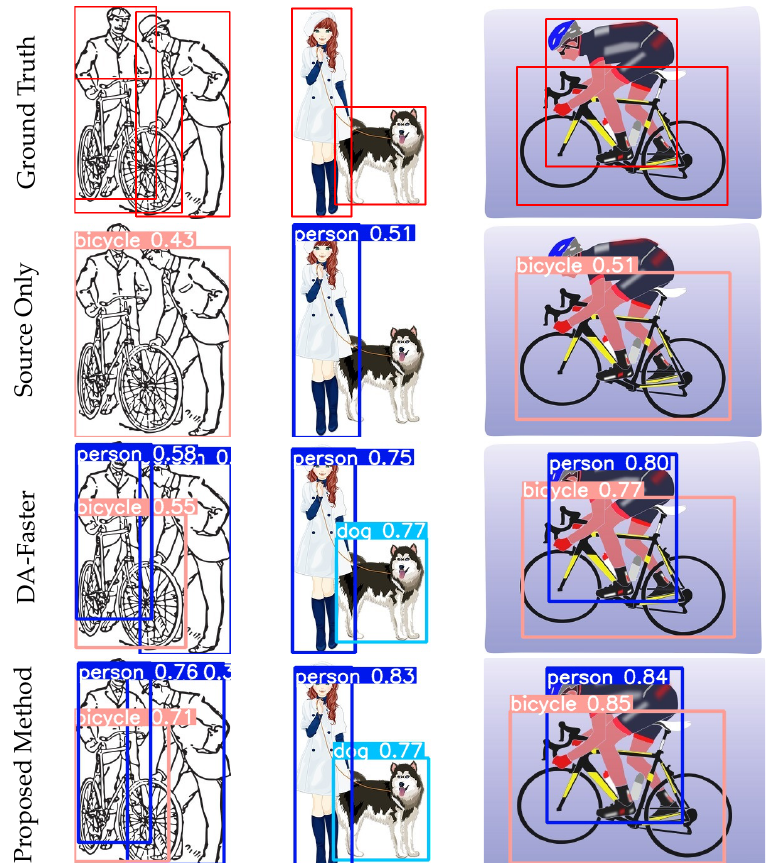
Figure 12. Qualitative results (Pascal VOC → Clipart). The Pascal VOC dataset is used as source domain, and the Clipart dataset is used as target domain. From left to right are the results from ground truth, source only, DA-Faster, and proposed method.